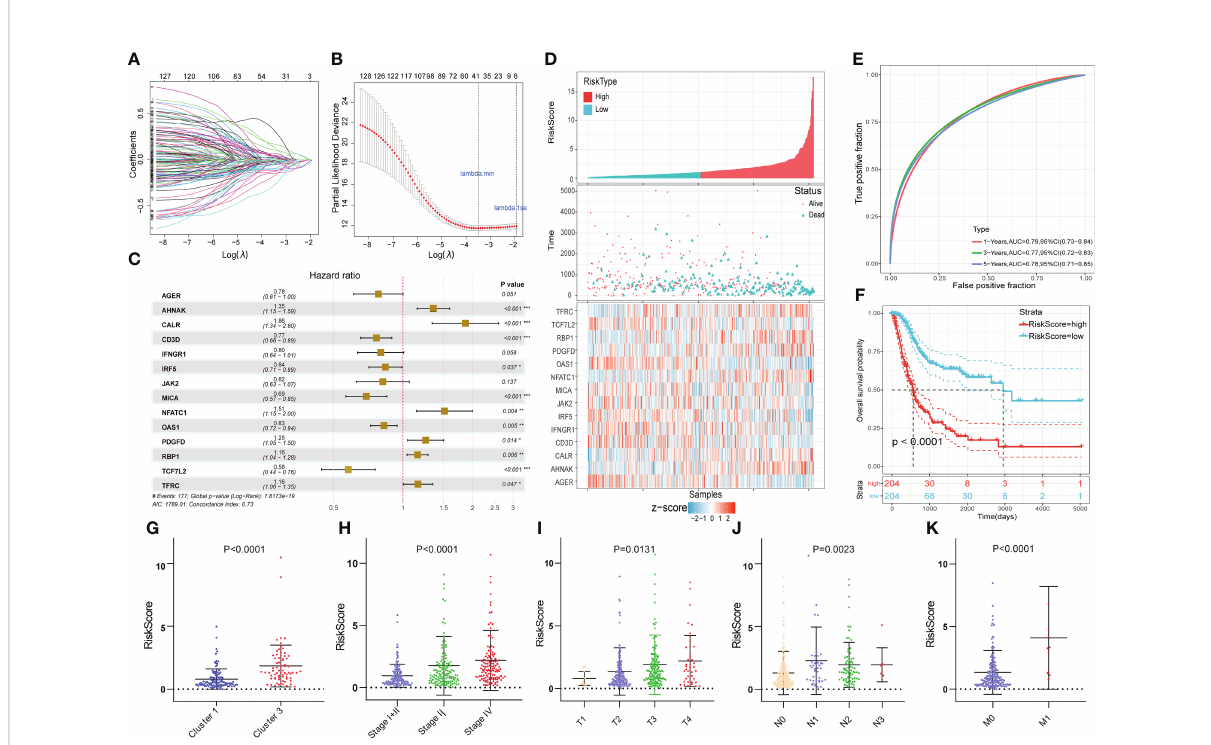
FIGURE 4 Construction of the novel immune-related gene signature based on EMT and metabolic status. (A, B) The LASSO regression was used to reduce the dimensionality of survival related genes after univariable Cox survival analysis. (C) Stepwise multivariate Cox regression analysis to construct the 14-gene prognostic signature. (D) The heatmap of the 14-gene expression and the distribution of patient survival status ranked by corresponding RS. (E) The time-dependent ROC curve for predicting 1-, 3-, and 5-year overall survival in TCGA cohort. (F) The KM survival analysis between high and low RS groups. (G-K) The correlation between RS and clusters, clinical stage and AJCC TNM stage. *p<0.05, **p<0.01,